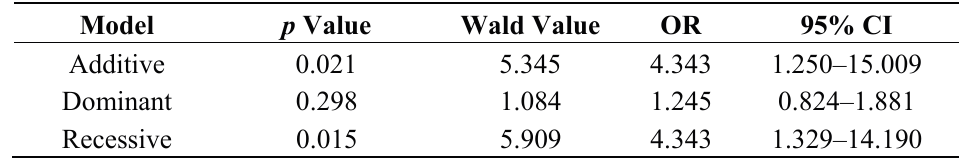
Table 3. Associated between rs187238 variant with risk for idiopathic recurrent miscarriage after adjustment for Binary Logistic